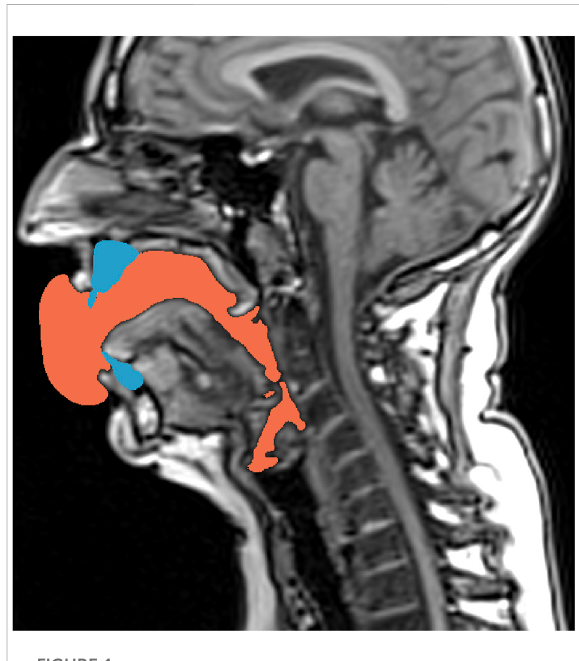
FIGURE 1 Exemplarily shown for Belting /a ː / (A X 3),themid-sagittal slice of the MRI stack shows the air- fi lled cavities in black color. Additionally, the post-processed teeth models (blue) and the fi nally derived segmentation of the vocal tract cavity used in the FE calculation (orange) — considering the teeth not shown in the primary MRI data – are